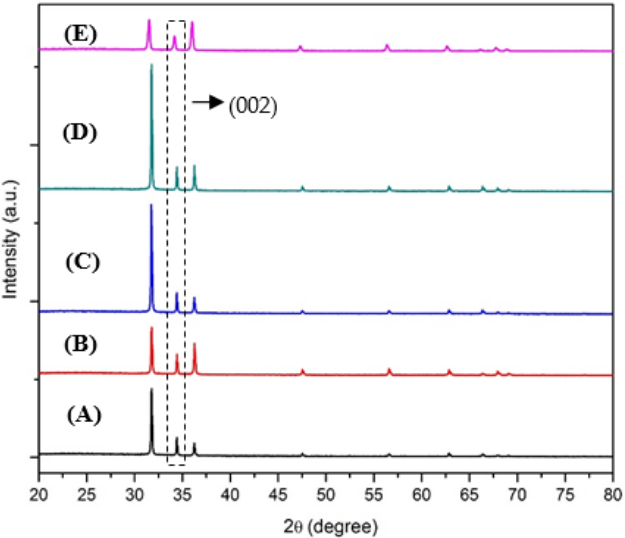
Figure 5. XRD pattern of ZnO microrods on Zn-Pandan seed layer annealed at: ( A ) 100, ( B ) 200, ( C ) 300, ( D ) 400, and ( E ) 500 °C.